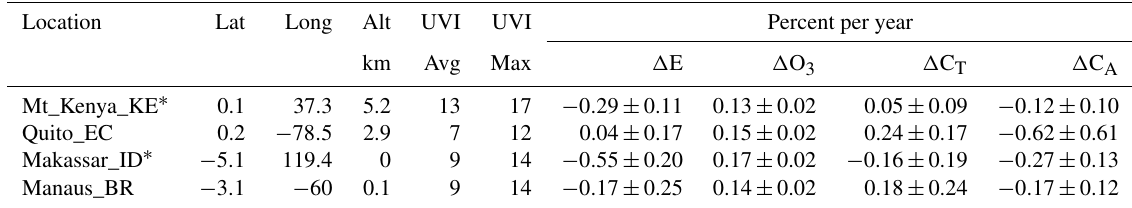
Table 3. Summary of four equatorial sites (errors are 1 σ ).